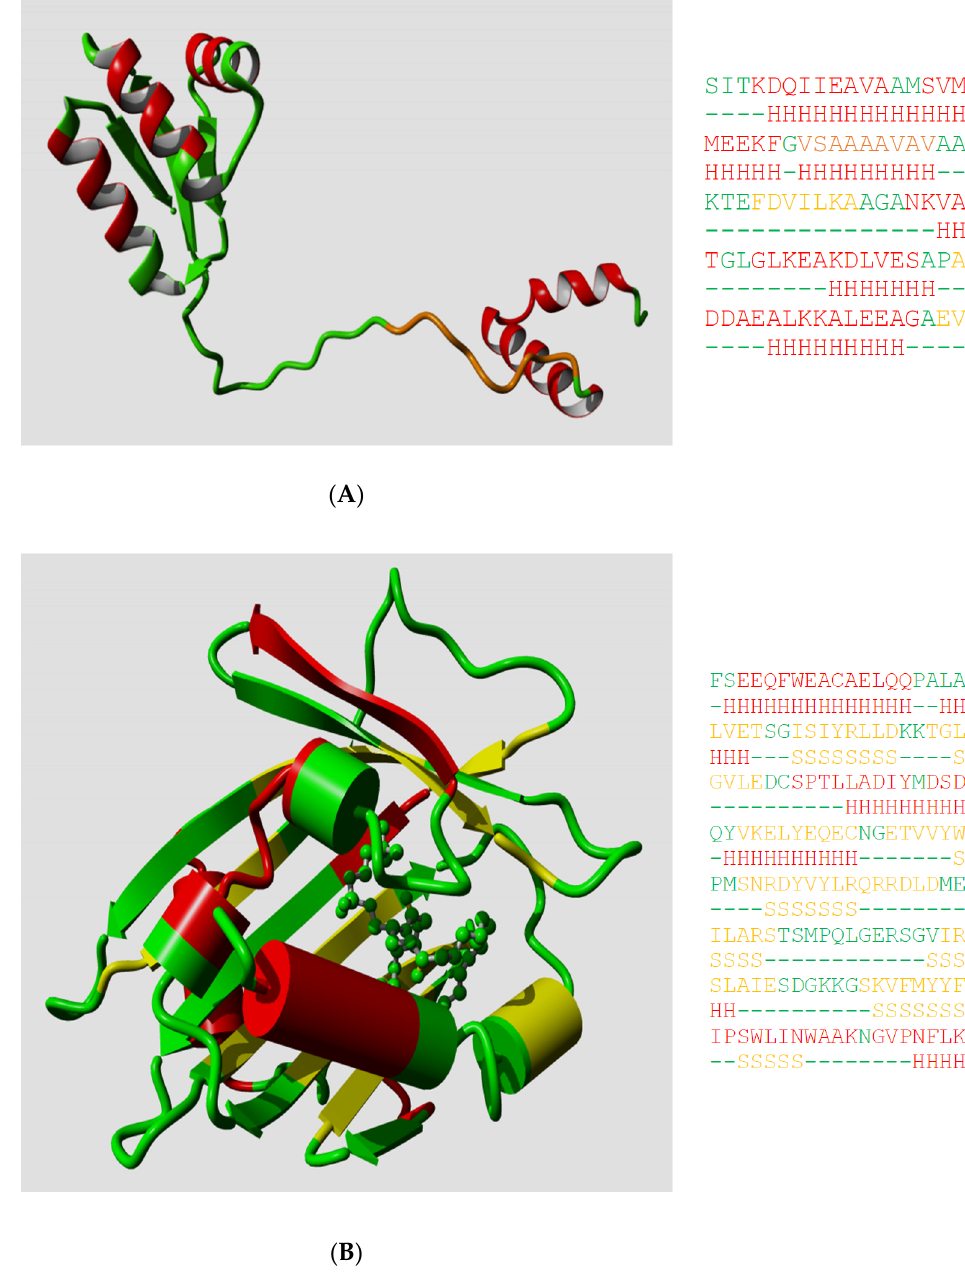
Figure 1. ( A ) The structure of one monomer of the L7 / L12 protein dimer. PDBid 1rqu [20] is colored by the helix predictions made by Ptitsyn et al. in 1973 (helix = red; nonhelix = green). The small orange stretch was predicted as helix by Ptitsyn et al., but falls in a region for which no NMR data is available, but for which Bocharov et al. [20] wrote “There is an indirect evidence of the existence of transitory helical structures at least in the first part (residues 33–43) of the hinge region”. To the right the sequence is shown colored by its secondary structure with underneath it the predicted secondary structure. Helices are green, strands are yellow, and everything else is green. Loops are shown as dashes. ( B ) The structure of the phosphatidylcholine-transfer protein from bovine liver. PDBid 1ln3 [21] is colored by the secondary structure predictions by Akeroyd et al. [22] using the methods of Chou and Fasman, and Lim as implemented by Lenstra [14]. (same coloring as in A). Many things can be said about this prediction, but not that it could have been useful for any practical purpose. The sequence and predicted secondary structure to the right are also colored as in A.